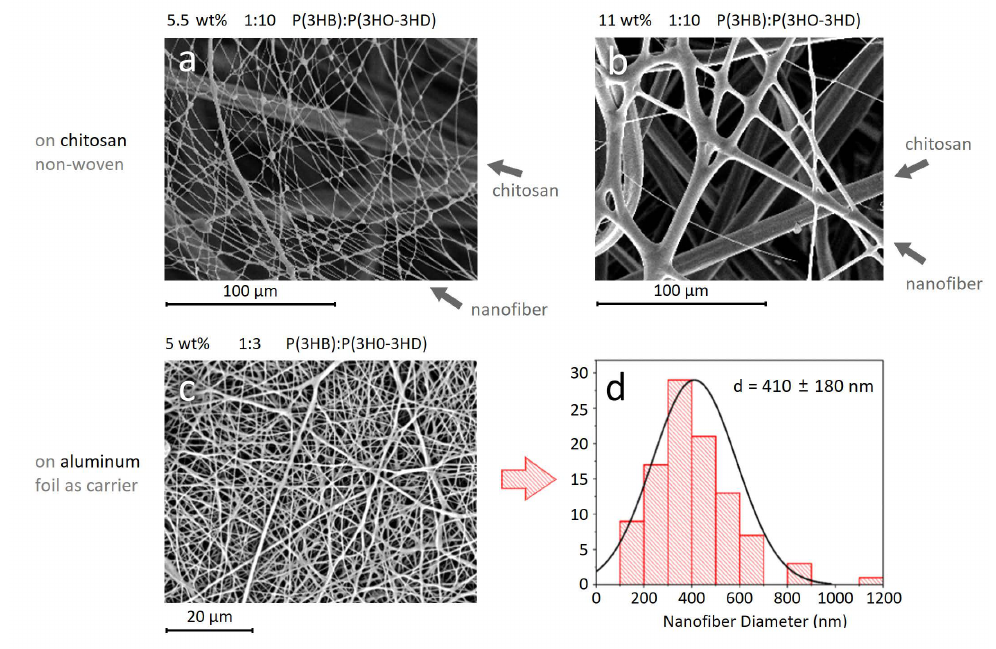
Figure 4. P(3HB)/P(3HO-co-HD) nanofibers with a concentration of ( a ) 5.5 wt%, ( b ) 11 wt% nanofibers, on chitosan carriers that are visible as thick fibers in the background. ( c ) SEM image and ( d ) histogram of the optimized P (3HB)/P(3HO- co -3HD)